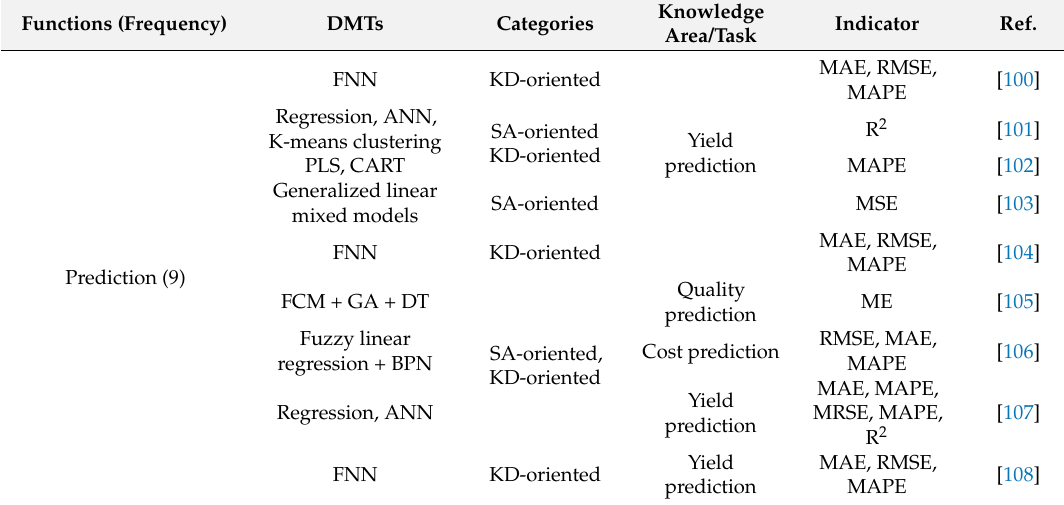
Table 12. DM with Big Data application for the quality improvement at the production stage. Functions